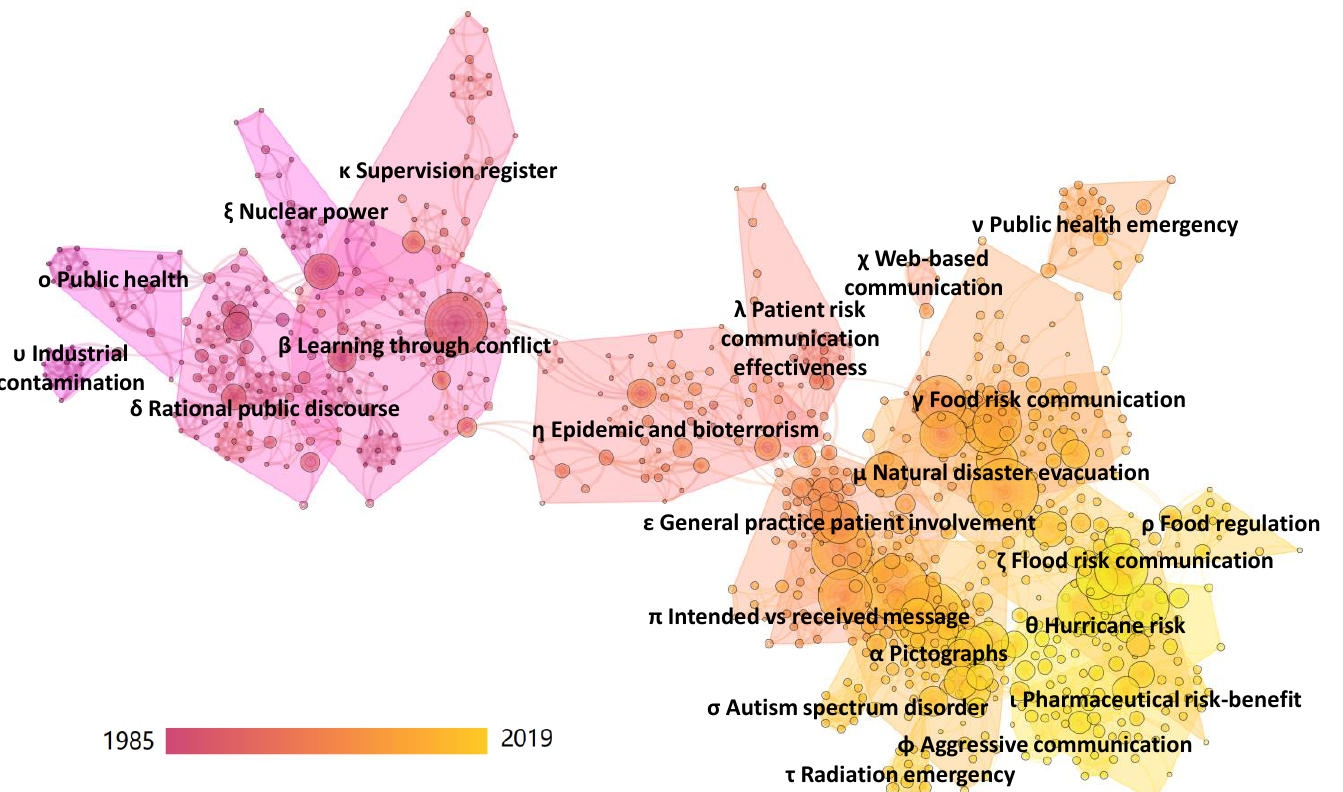
Figure 9. Clusters of co-citation network of risk communication research.